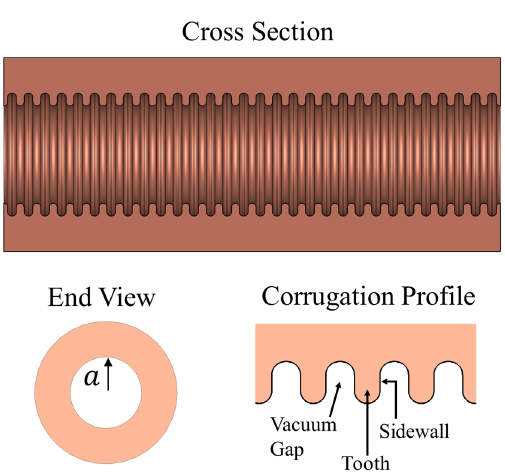
FIG. 2. Cylindrical corrugated waveguide (CWG) with minor radius a . The specific design used in A-STAR has a ¼